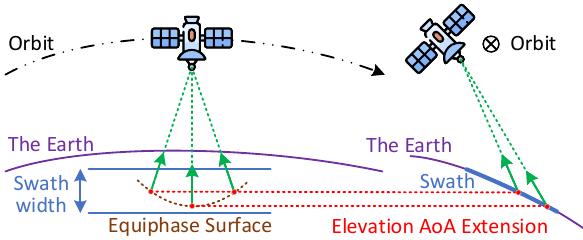
Figure 6. The geometry diagram of the elevation AoA extension phenomenon.